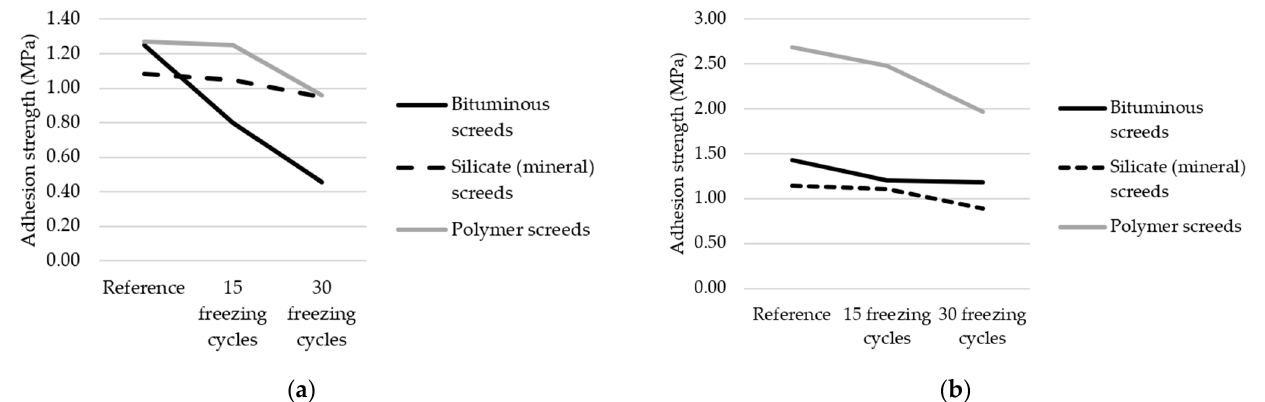
Figure 16. ( a ) Loss of strength—ceramics; ( b ) loss of strength—lime sand.